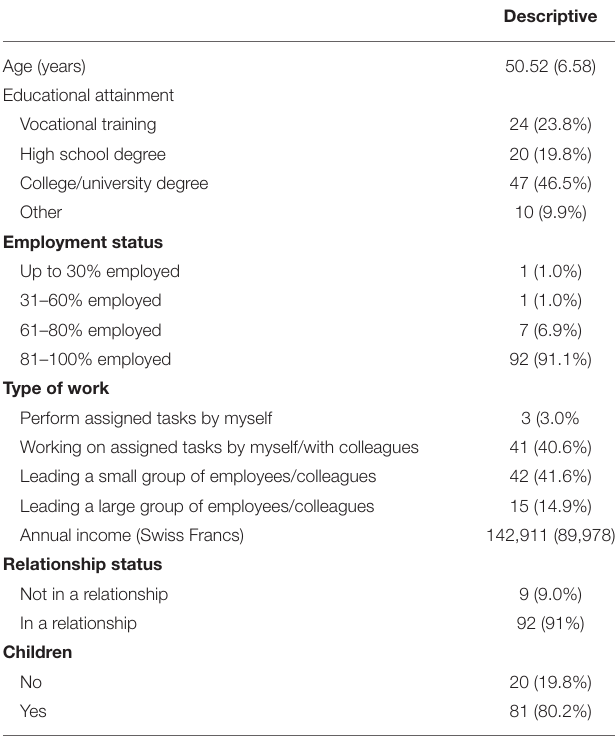
TABLE 1 | Characteristics of the sample ( N = 101); data are presented as mean and standard deviation (for age and annual income) or absolute and relative